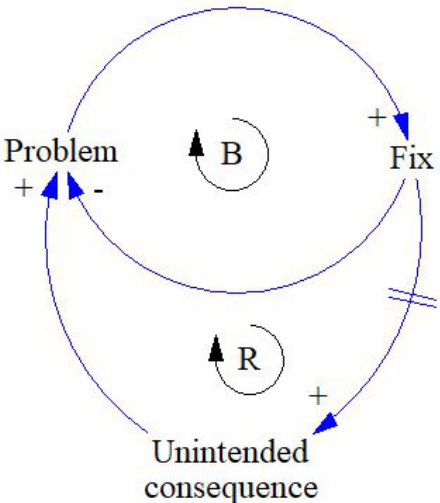
Figure 4. The Causal Loop Diagram (CLD) of the “fixes that fail” or “fixes that backfire” system archetype. In this particular setting, the implemented fix alleviates the problem in the short-run but results in unintended consequences in the long-run that can make the situation worse and necessitate additional fixes. “B” refers to a balancing loop and R refers to a reinforcing loop. Double bars reflect lag time.